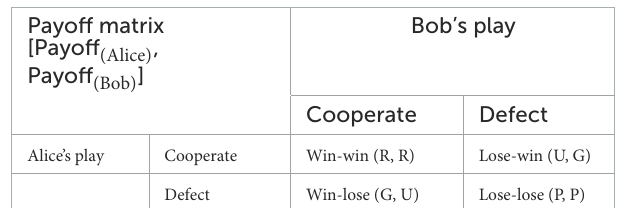
TABLE 1 Generalized payoff matrix of prisoner’s